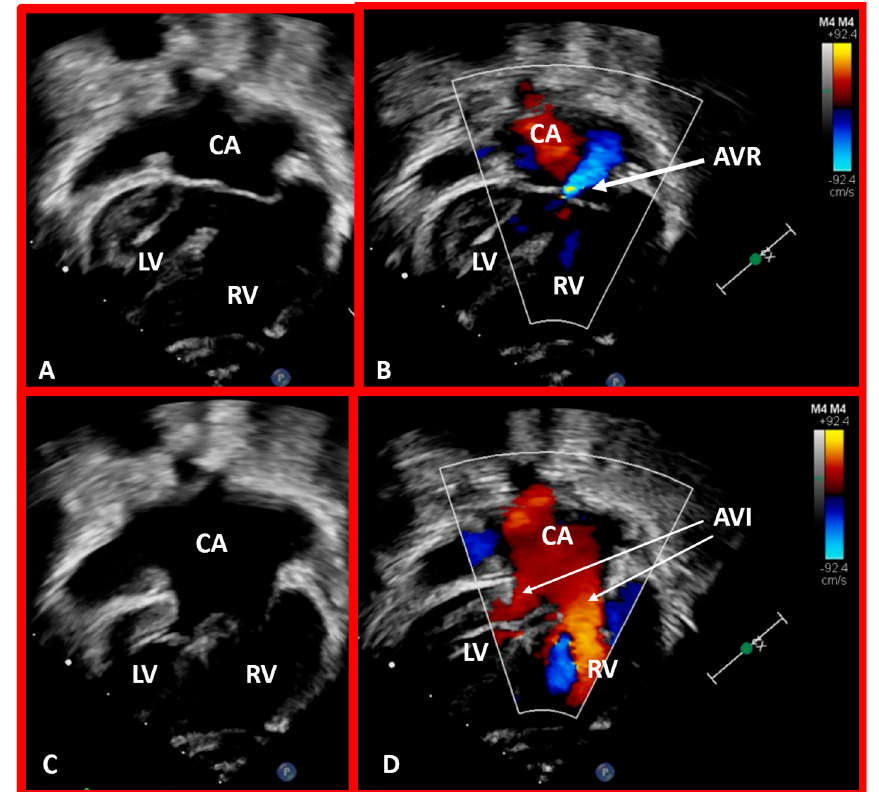
Figure 43. Echo frames in apical four-chamber views demonstrating a connection of common atrium (CA) with single ventricle (SV) by a one (common) atrioventricular valve. In ( A ), the common atri- oventricular valve is closed (C), whereas in ( B ), it is open (O). Heavy trabeculation is seen in the SV.